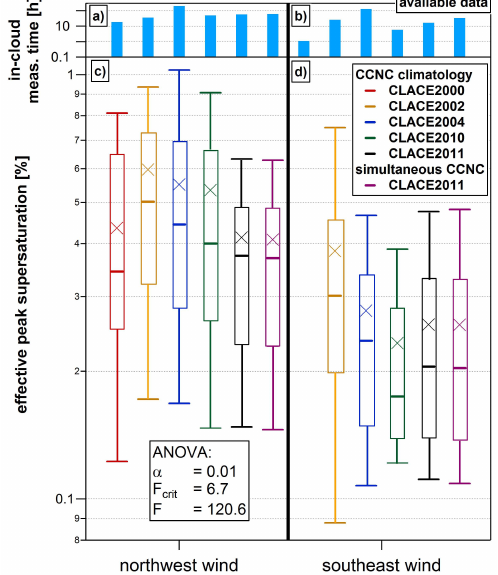
Fig. 7. In-cloud measurement time during the CLACE campaigns for (a) northwestern wind (local wind direction is between 225 ◦ to 45 ◦ ) and (b) southeastern wind (225 ◦ to 45 ◦ ). 10th, 25th, 50th (me- dian), 75th, and 90th percentiles (boxplot) and mean value (cross) of the effective peak supersaturation (SS peak ) for (c) northwestern and (d) southeastern wind. The F value of the ANOVA is much larger than the critical F value for α = 0 . 01, which indicates a signifi- cant difference between the mean SS peak for all data under north- western and southeastern wind conditions. For CLACE2011 SS peak has additionally been retrieved with using the concurrent CCNC measurements (purple) alternatively to using the climatology data (black). The statistics for southeastern wind during CLACE2000 is not shown because only 1.1h of valid in-cloud data is